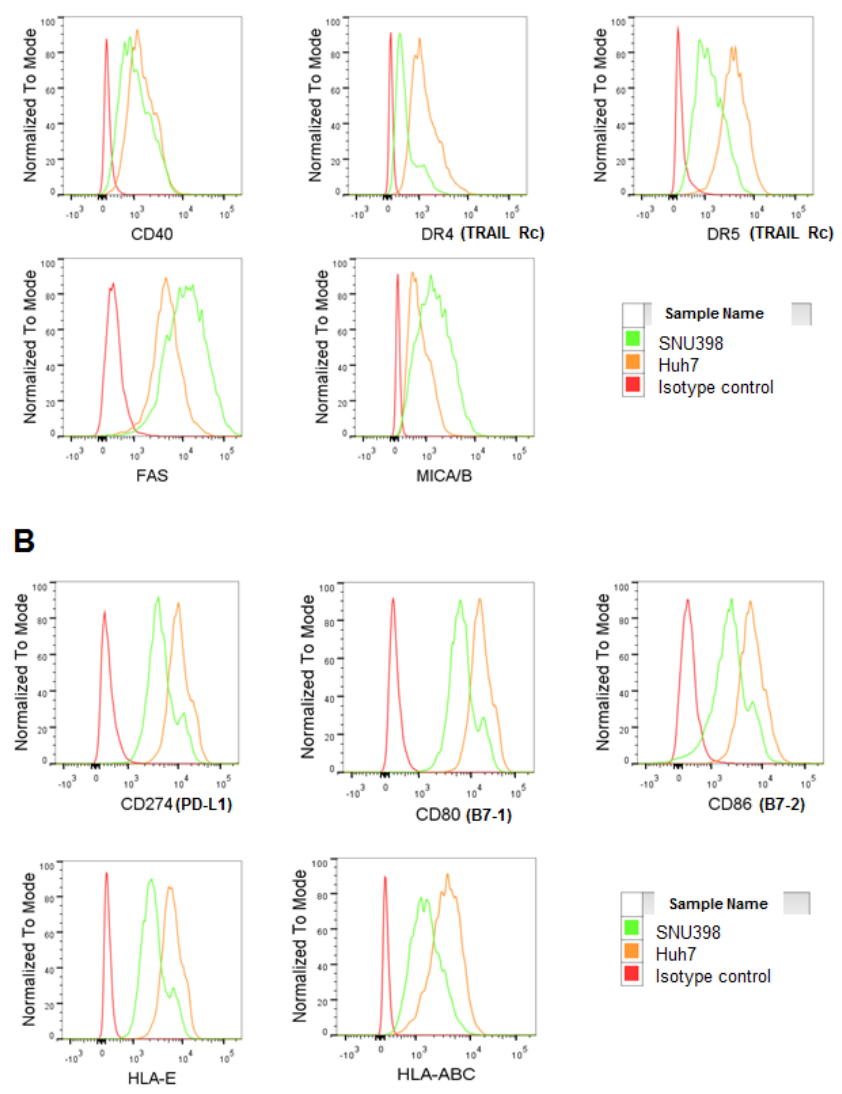
Figure 4. Higher expression of FAS and NKG2D ligands on SNU398 cells. ( A ) Representative plots of activating ligands of NK cells and cell death receptors on the surface of SNU398 and Huh7 are shown. ( B ) Representative plots of inhibitory ligands on the surface of HCC cells are